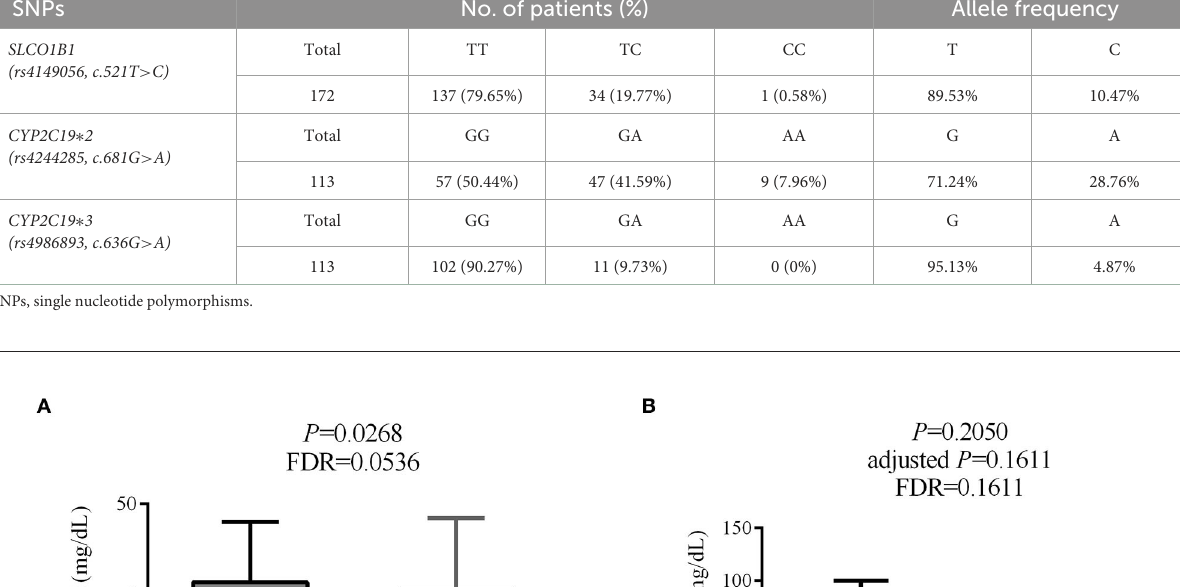
TABLE 5 Distribution of genotype and allelic frequency of polymorphisms of SLCO1B1, CYP2C19 genes in CAD patients. SNPs No. of patients (%) Allele frequency SLCO1B1 (rs4149056, c.521T > C)